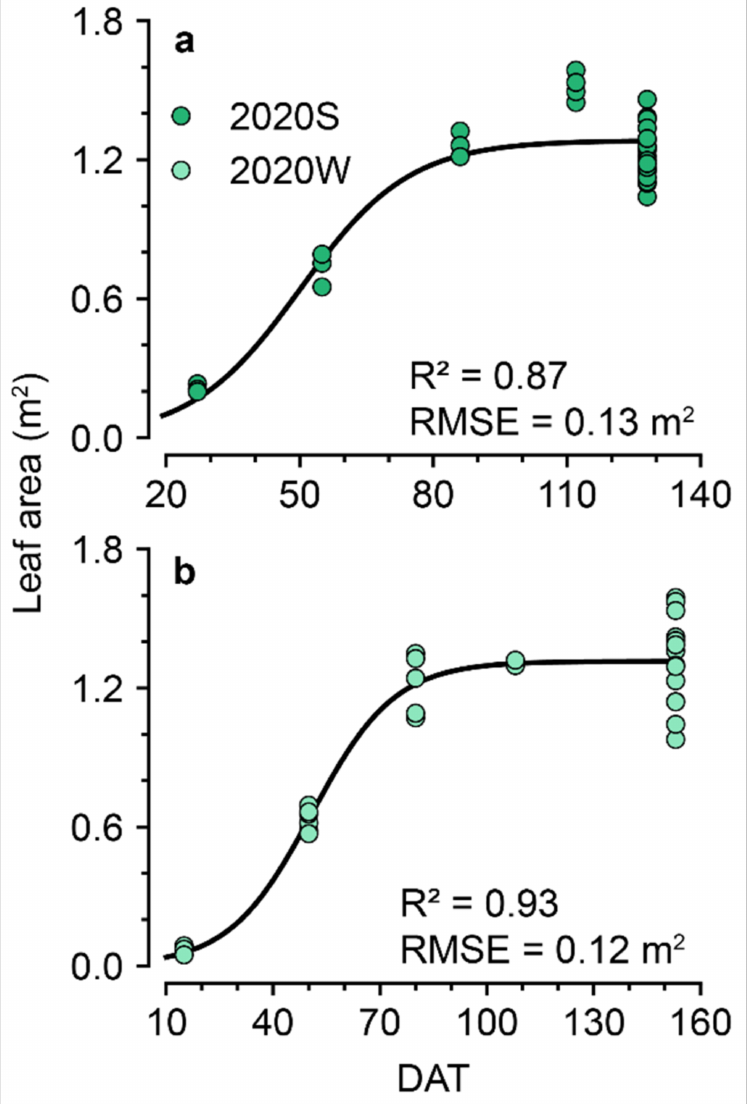
Figure 7. Regressed leaf areas and regression accuracies. The leaf areas from 26 February 2020 to area was regressed to a sigmoidal function. Refer to Supplementary Table S3 for the fitted